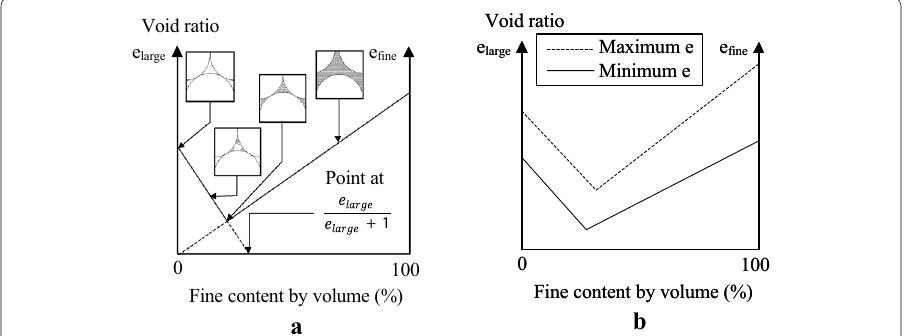
Fig. 1 a Theoritical variation of void ratio and void filling with fine contents, and b variation of maximum and minimum void ratio with fine contents (modified from Lade et al.